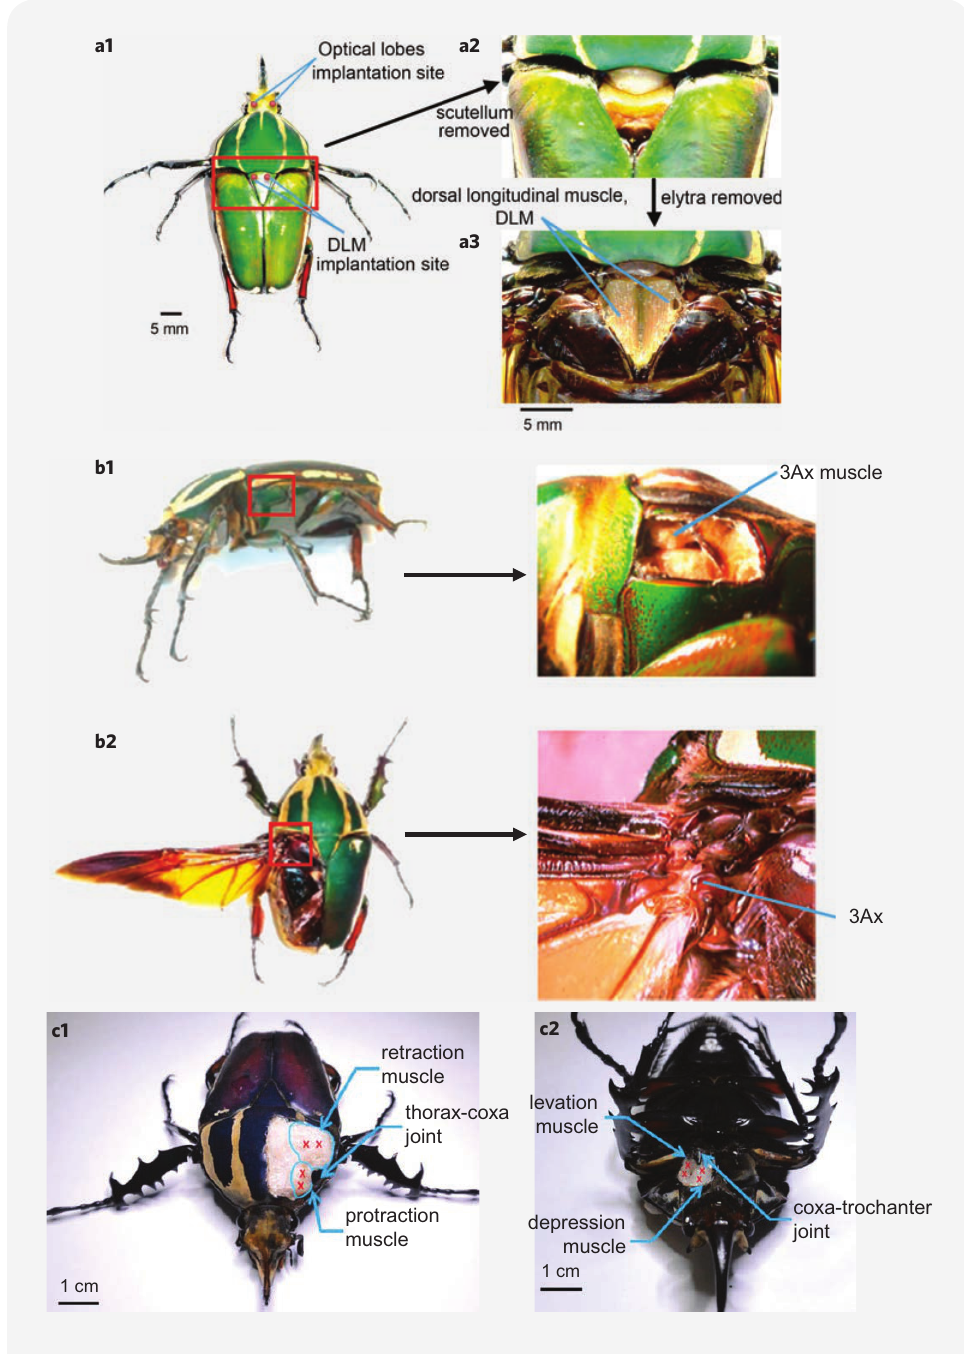
Figure 1. Anatomical views of a beetle and the implantation sites for electrical stimulation. (a1) Dorsal view of a beetle with the implantation sites for neuronal stimulation of the optic lobes and muscular stimulation of the dorsal longitudinal muscles (DLM) marked. Electrodes were inserted through small holes bored in the scutellum into muscle tissue and in the head into optical lobes. Close-up views of the dorsal thorax (a2) after removal of the scutellum and (a3) after exposing the dorsal longitudinal muscles. Side view (b1) and dorsal view (b2) of a beetle. The insets are close-up views of the red squares showing the third axillary (3Ax) muscle (upper) and 3Ax sclerite (lower). (c1) The protraction and retraction mus- cles enable the leg to move forwards and backwards about the thorax–coxa joint. (c2) The levator and depressor muscles enable elevation and depression of the leg about the coxa–trochanter joint. Red crosses denote the implantation sites for the stimulated